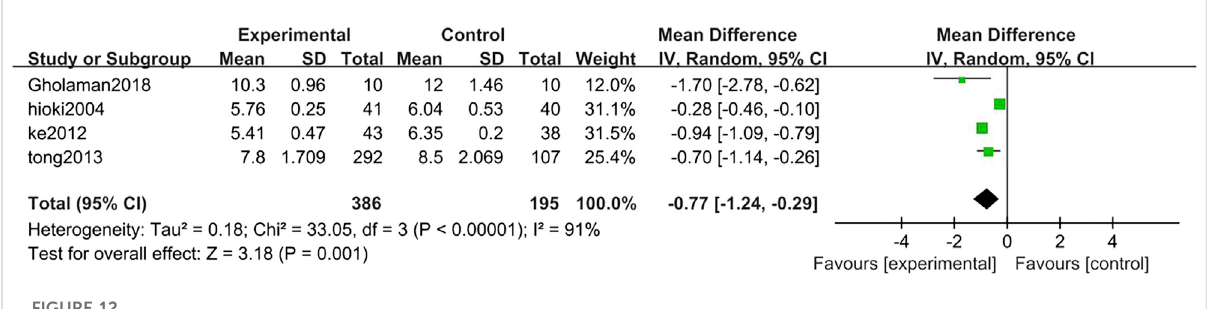
FIGURE 12 Forest plot of FBG. Comparison: TCM treatment vs. placeo or blank control.